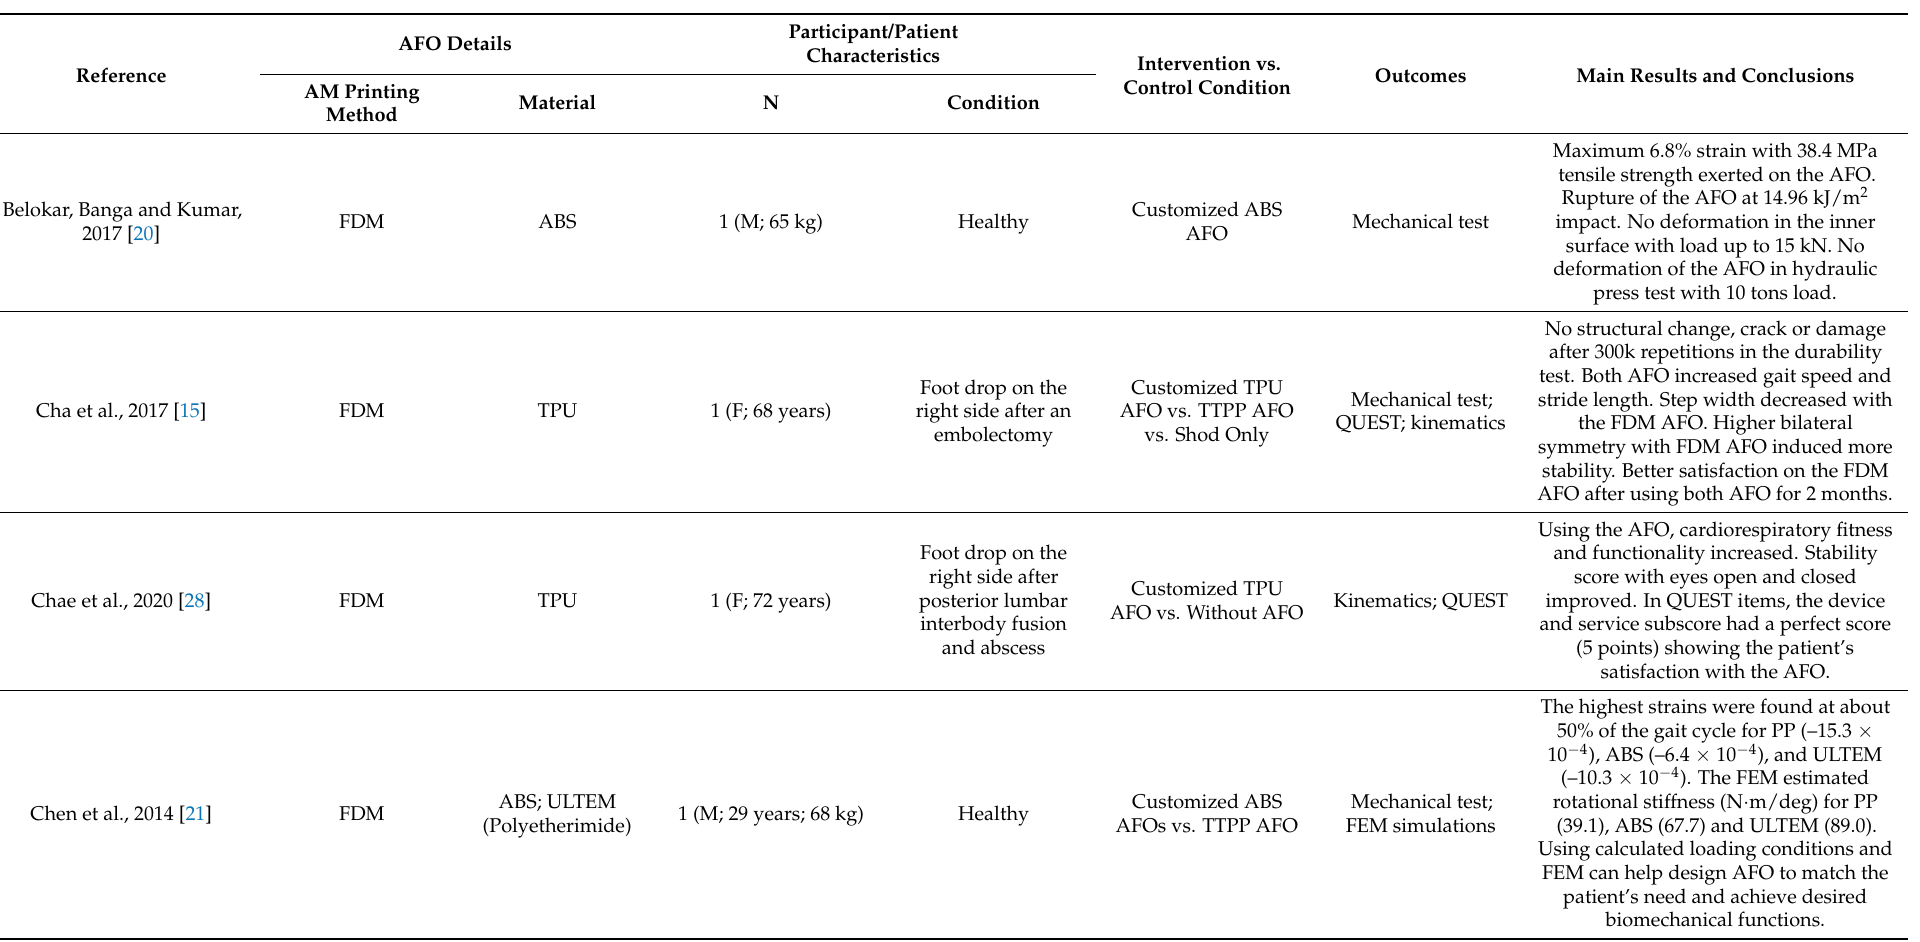
Table 1. Included studies with AFO details, participant/patient characteristics, intervention and control conditions, outcomes, and main